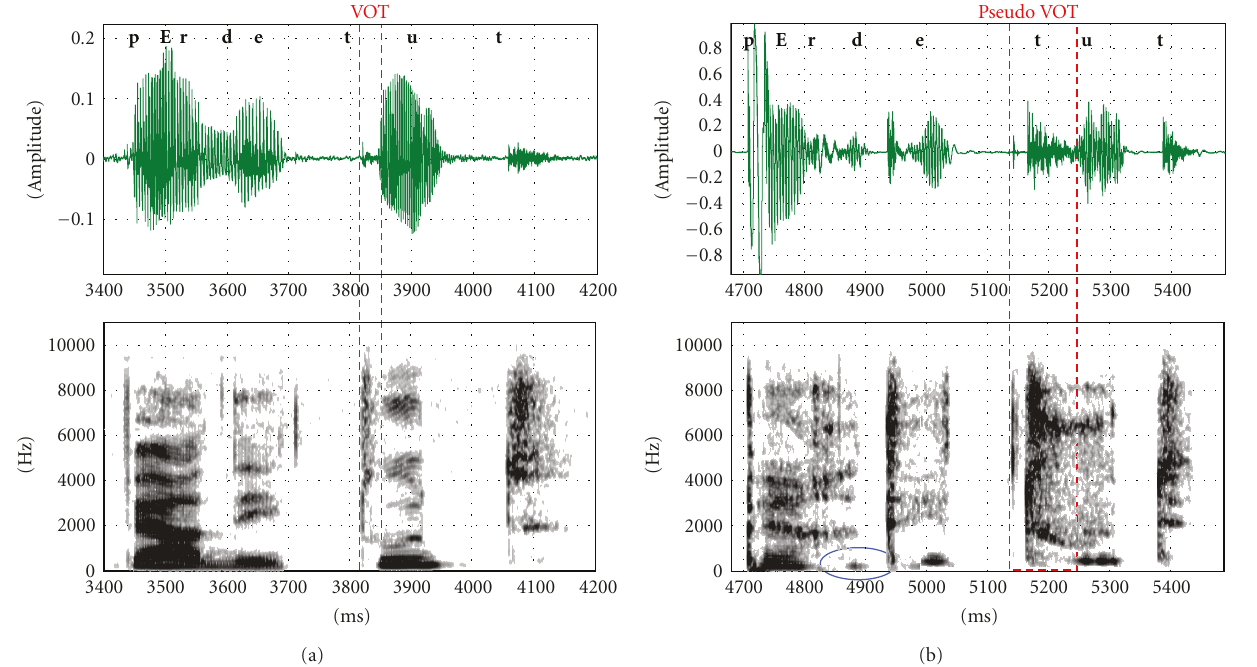
Figure 6: Oscillogram and spectrogram for the extract “[ ··· ] perdait toutes [ ··· ]”/pErdetut/; grade 0 on the left (normal voice), grade 3 on the right (severe dysphonia). On the right, we can note (1) the abnormal extension of the voice onset time (VOT) on the unvoiced plosive/t/. The consonant is quasi transformed in fricative (spirantisation), (2) the quasi unvoiced consonant/d/ transformed